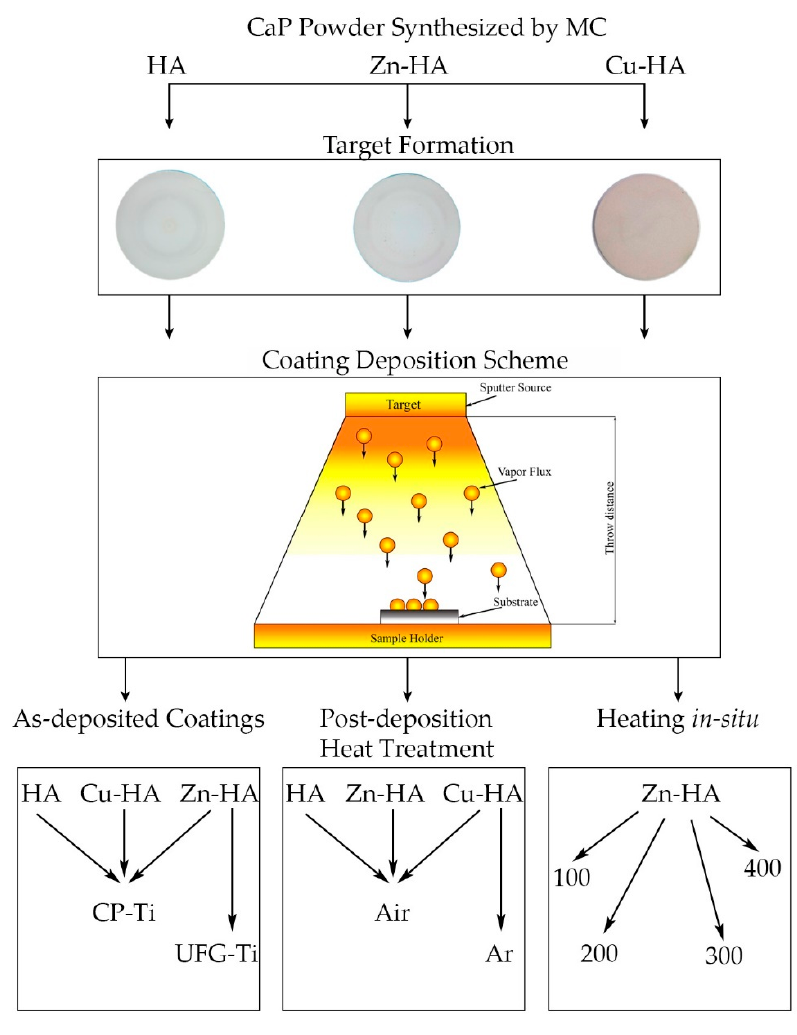
Figure 2. Workflow of the study.